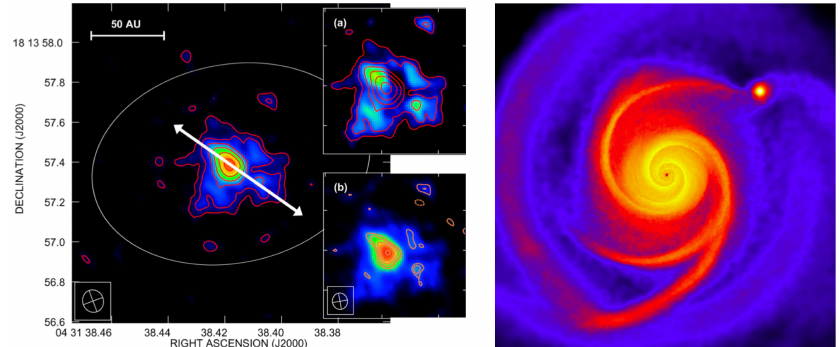
Figure 24. From Rice [66]. ( Left panel ): A radio image of the HL Tau system showing excess emission at ∼ 65 AU (upper right quadrant of the left-hand images), which could be a protoplanet in formation. ( Right panel ): A simulation showing how such an object could indeed form, through direct gravitational collapse, in the outer parts of a disc like that in the HL Tau system.